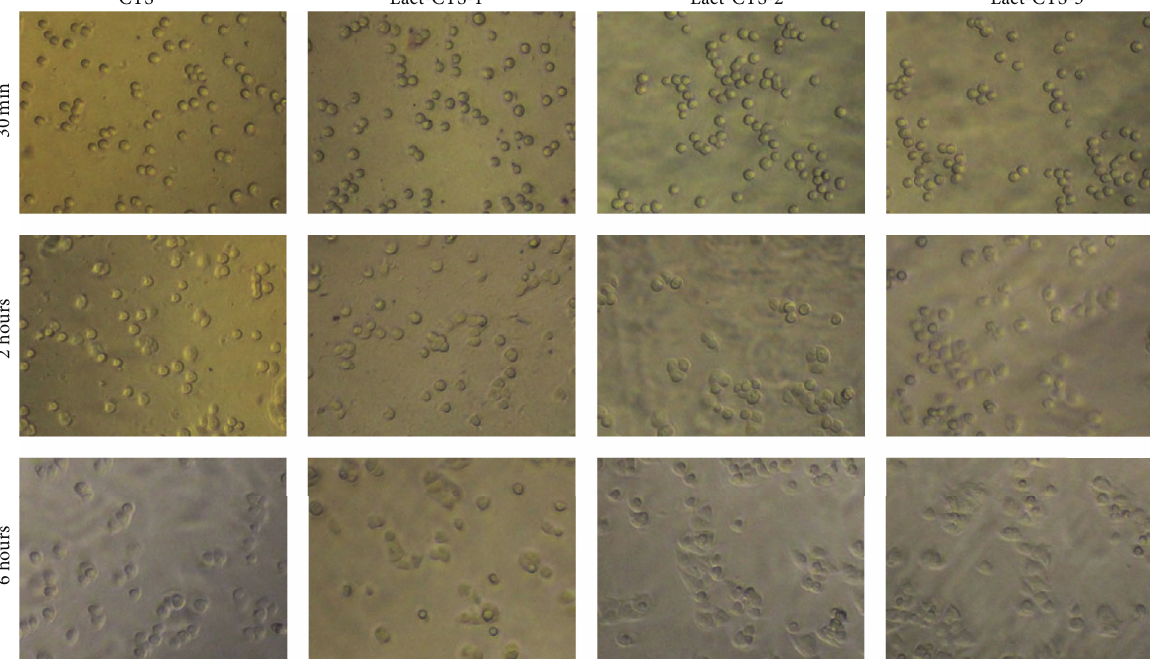
Figure 6: The hepatocytes adhered to CTS, Lact-CTS-1, Lact-CTS-2, and Lact-CTS-3 films under a phase contrast microscope